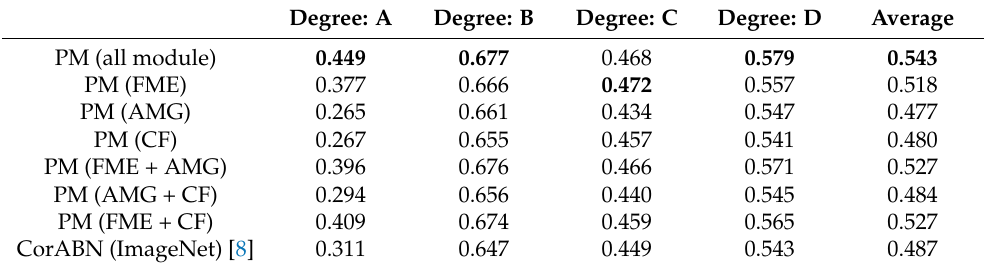
Table 11. F1-scores of eight methods for rebar corrosion. A total of seven PMs is composed of the six cases of introducing the parameters of contrastive learning to some modules in CorABN and the case of all modules. Each method’s name contains the module that introduced the parameters of contrastive learning. FME, AMG, and CF correspond to the feature map extractor, attention map generator, and classifier, respectively. In addition, we used CorABN using ImageNet parameters following the study [8]. The best scores for each degree and the average are presented in